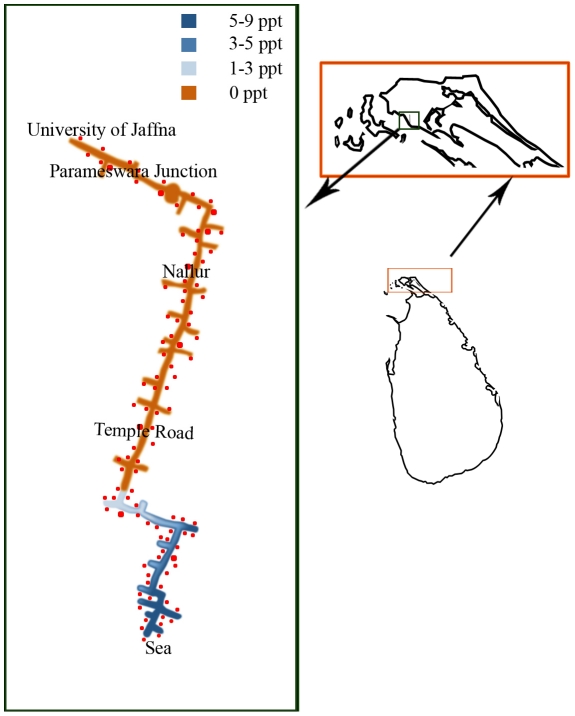
Salinity in domestic wells from the Jaffna coast to Thirunelvely.The results show the changes in salinity in domestic wells that were examined for Aedes larvae along a 6 km stretch of the main road from the Jaffna coast to the University of Jaffna campus in Thirunelvely.